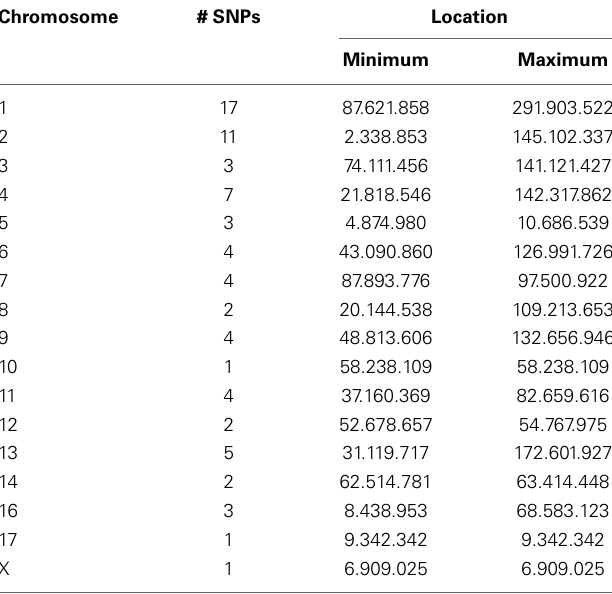
Table 2 | Distribution of SNPs over the chromosomes in the Tan Module using the WISH network method based on genotypic